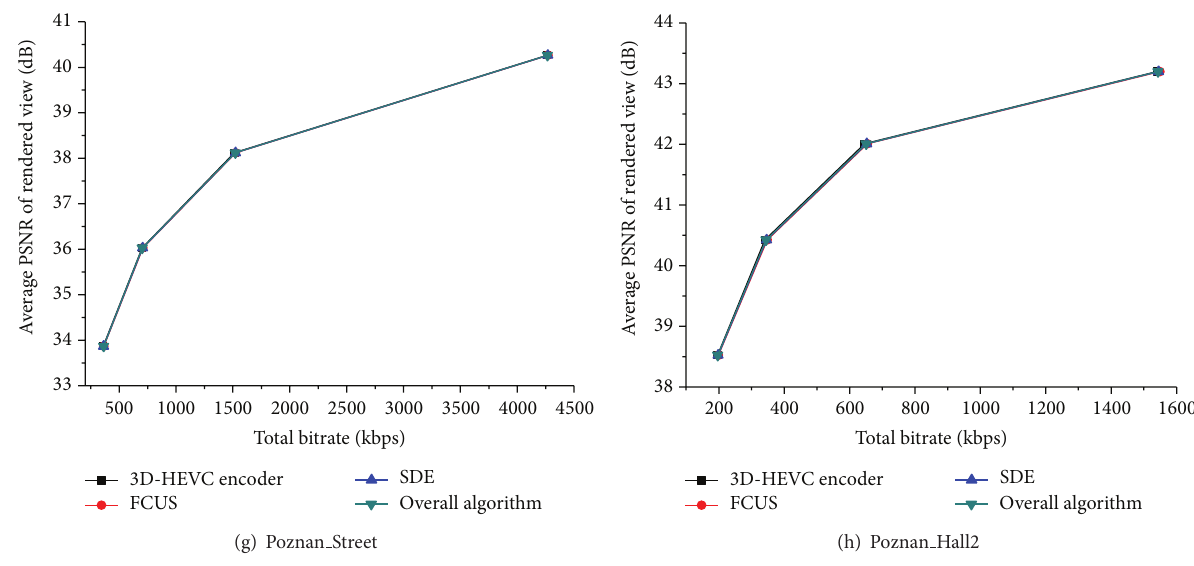
Figure 4: Rate-distortion curves comparison. The 𝑥 -axis denotes total bitrate to code three texture videos and three depth maps. The 𝑦 -axis denotes average PSNR of the rendered views. Table 6: Comparing the proposed overall algorithm with a state-of-the-art fast algorithm in